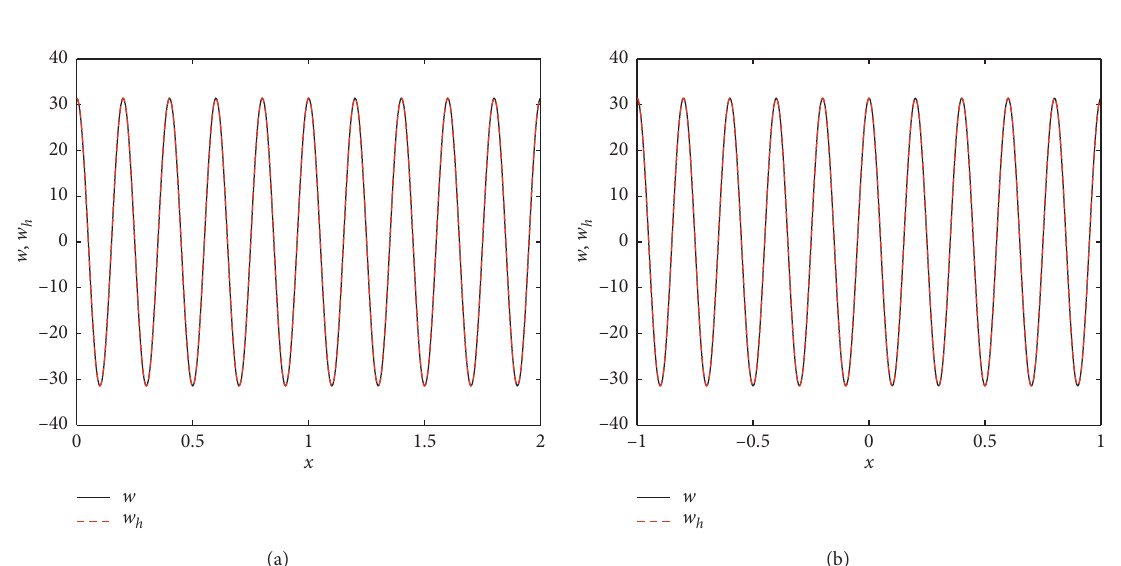
Figure 1: The exact solution w (solid line) and LDG solution w